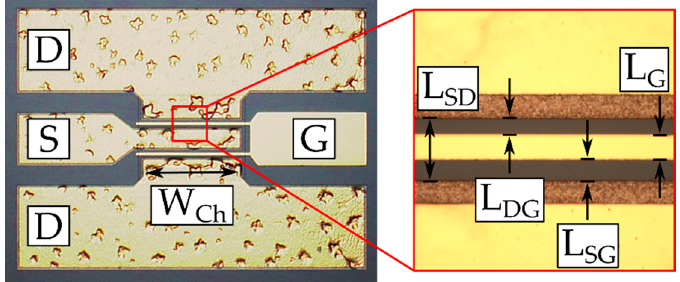
Figure 3. Microscope image of the radio frequency (RF) T-HEMT (left hand side) and details of the design parameters (right hand side) illustrating the Gate (G), Source (S), and Drain (D) electrodes in a 150- μ m pitch implementation.